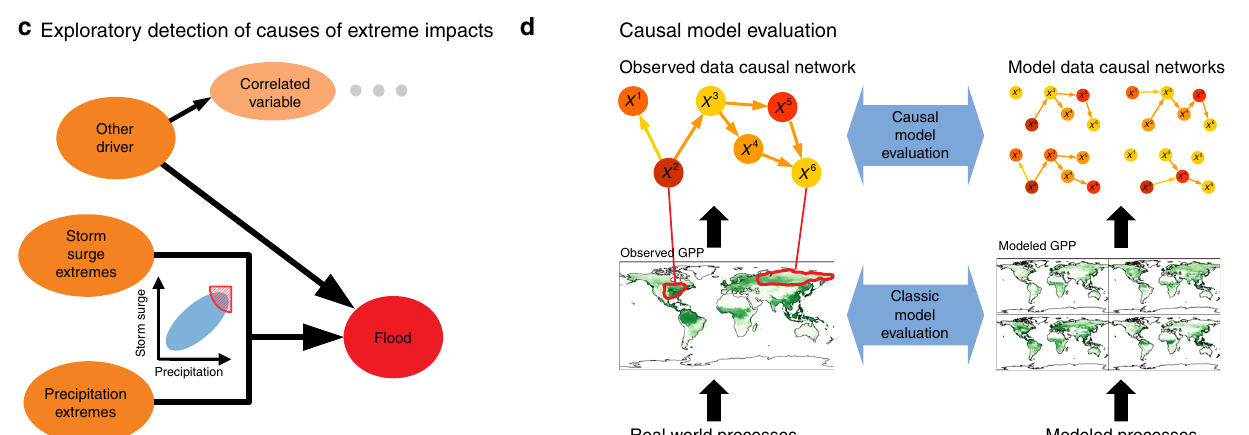
Fig. 3 Key generic problems in Earth system sciences. a Causal hypothesis testing in climate research. The question of how the position of the jet stream depends on Arctic and tropical drivers is challenging due to different temporal scales and the spatial de fi nition of variables (hatched regions). b Climate network analysis attempts to describe dynamics of the Earth system using complex network theory. Basing this theory on causal network measures allows one to better interpret network properties. Here major tropical atmospheric uplifts were identi fi ed as causal gateways with strong average causal effect and average causal susceptibility in the network (more details in ref. 66 ). Nodes correspond to climatic subprocesses in different regions and the lower right graph illustrates the causal network metrics for a variable X : the average causal effect is the average change in any other component (node) induced by a one-standard-deviation increase (perturbation) in X . Conversely, the average causal susceptibility is the average change in X induced by perturbations in any other component. Here, the Out-Degree refers to the fraction of components signi fi cantly (at 5% level) affected by a component and correspondingly for the In-Degree. c Identifying drivers of extreme impacts is challenging due to the typically large amount of correlated drivers compared to much fewer causally relevant drivers, that, furthermore, may only in combination have a large effect (synergy). For example, a fl ood might require both storm surges and precipitation to be in an extreme state. Such types of dependencies are dif fi cult to represent with a pairwise network. d Basing model evaluation on causal statistics allows to better identify models with similar causal interaction structure as observational data, rather than comparing averages and climatologies. Shown is gross primary production (GPP) from observations and four illustrative models where the challenge lies in the extraction of variables (X 1 , X 2 , … ), here shown by some red encircled regions, as well as de fi ning suitable network comparison metrics (panel b) based on causal link weights (edge colors) and aggregate node measures (node